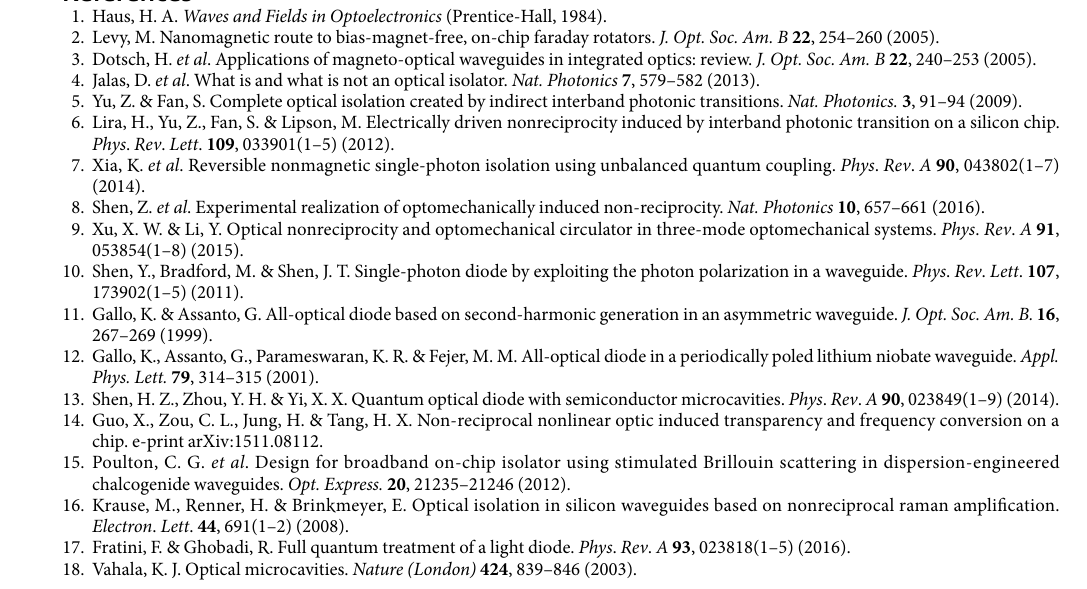
2 with J = 4 κ 2 and g = 2 κ 2 . The other system parameters are the same as in Fig. p 2